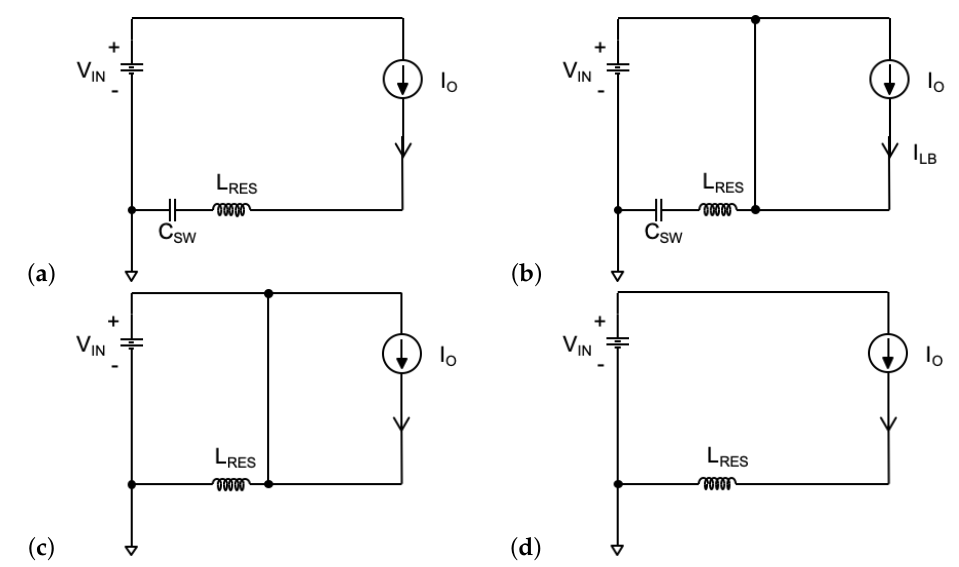
Figure 5. Equivalent Floating Buck ZVS-QRC Circuit in ( a ) Mode 1 (duration of t 01 ), ( b ) Mode 2 (duration of t 12 ), ( c ) Mode 3 (duration of t 23 ), and ( d ) Mode 4 (duration of t 34